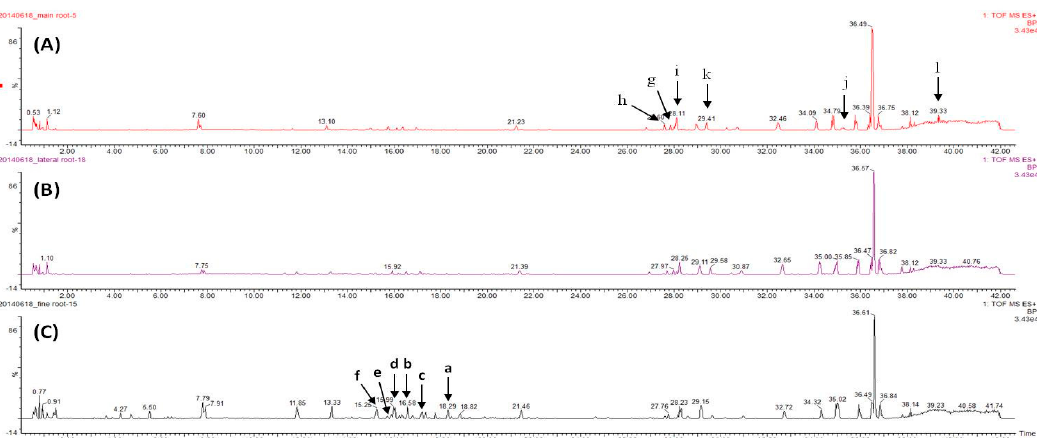
Figure 1. Base peak ion count chromatogram for the three components of red ginseng: ( A ): main roots; ( B ): lateral roots; ( C ): fine roots.